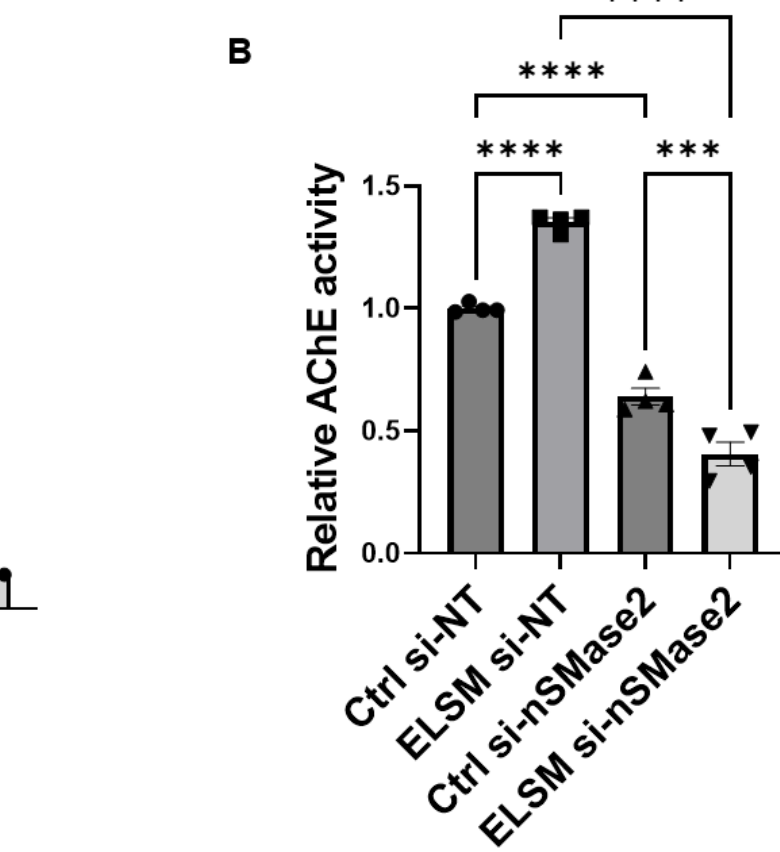
Figure 4. Knockdown of nSMase2 inhibits ELSM-induced EV release from C-MSC. ( A ) qRT-PCR quantification of nSMase2 mRNA levels (normalized to β -actin levels) in C-MSC transfected with nSMase2 siRNA (si-nSMase2) versus si-NT with/without ELSM treatment (* p < 0.05, *** p < 0.001, n = 3). ( B ) Quantification of relative AChE activity (normalized to protein concentration and then normalizing to the Ctrl si-NC group) in EVs from si-NT and si-nSMase2-transfected C-MSC with/without ELSM treatment (*** p < 0.001, **** p < 0.0001, n = 4).